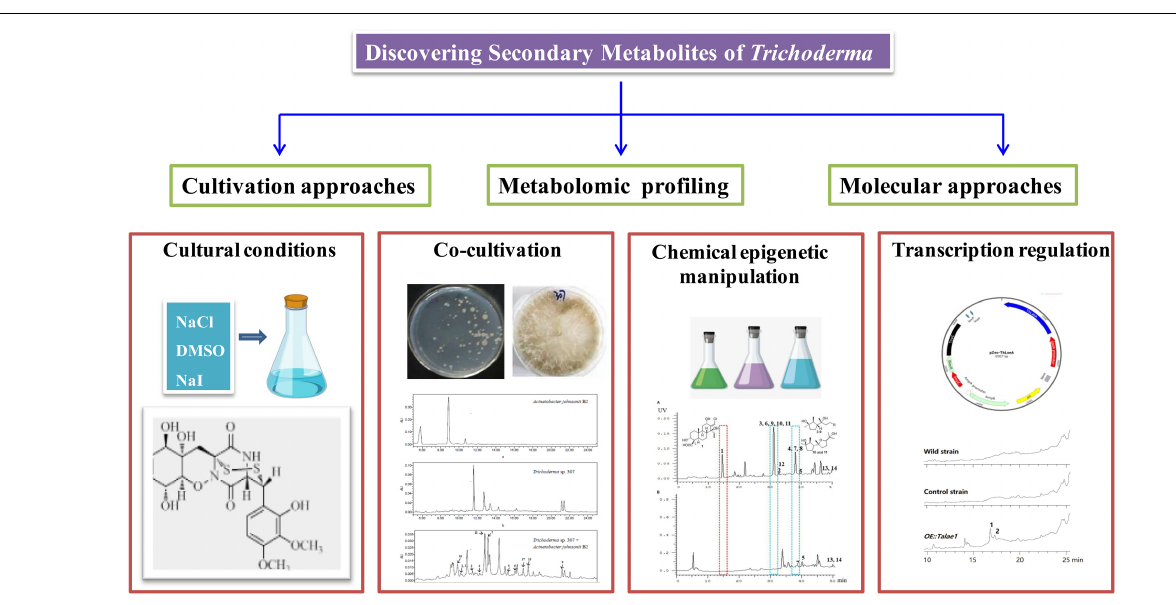
FIGURE 11 | New strategies for discovering secondary metabolites of